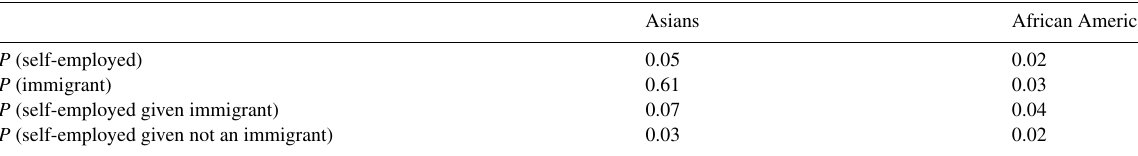
Table 12 Probability estimates of self-employment and immigrant status by race